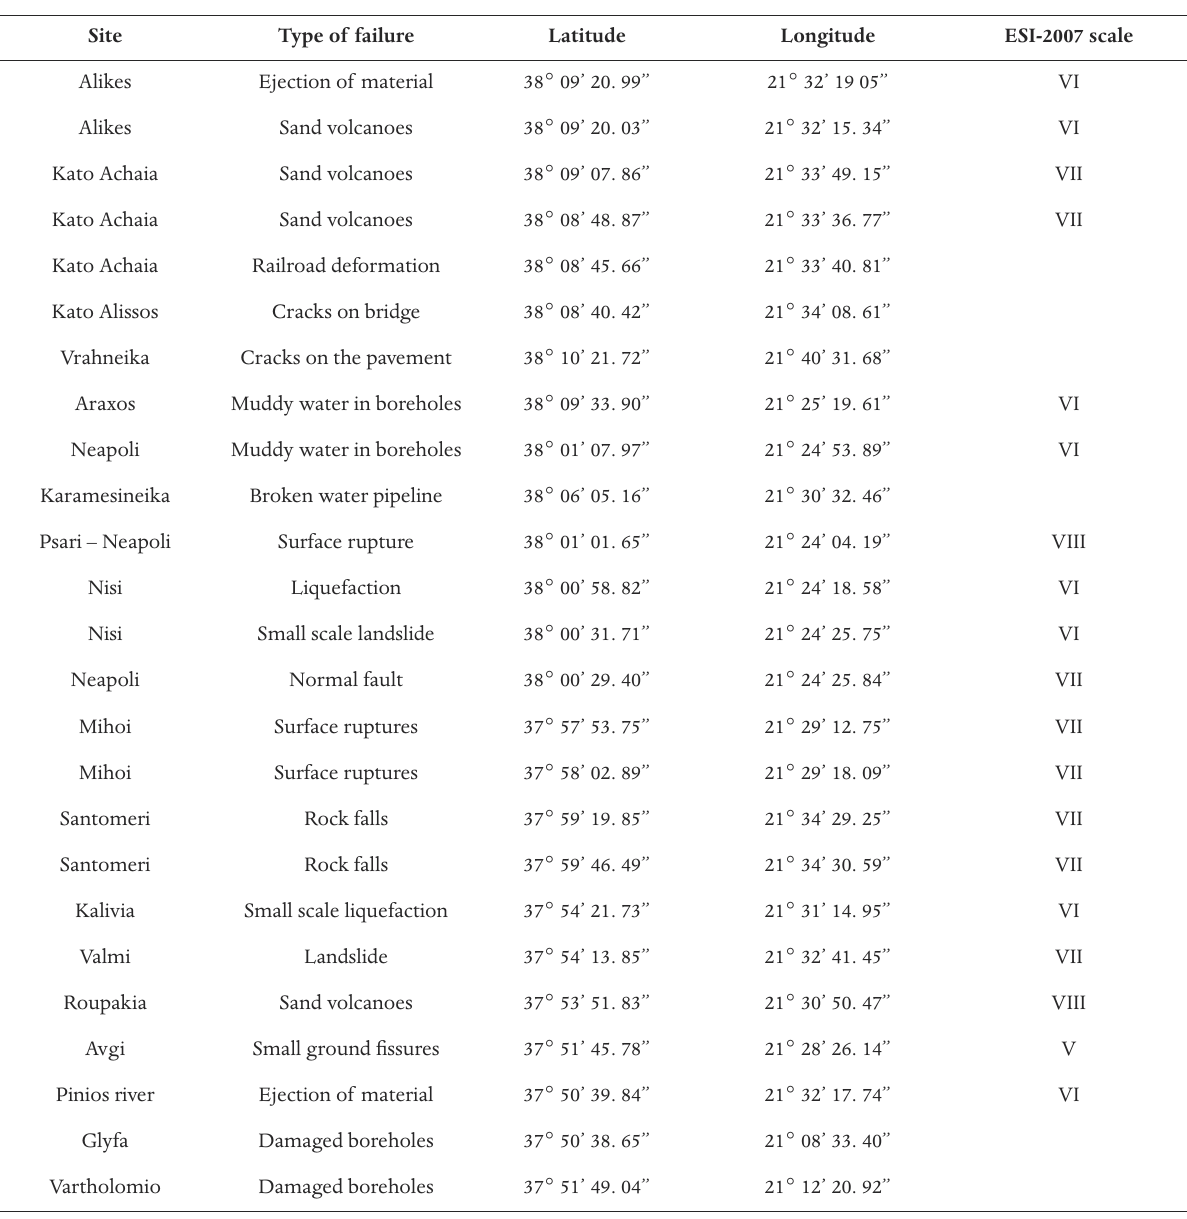
Table 2. Degrees of the seismic intensity that were evaluated based on ESI-2007 scale. The description of the environmental effects can be found in Section